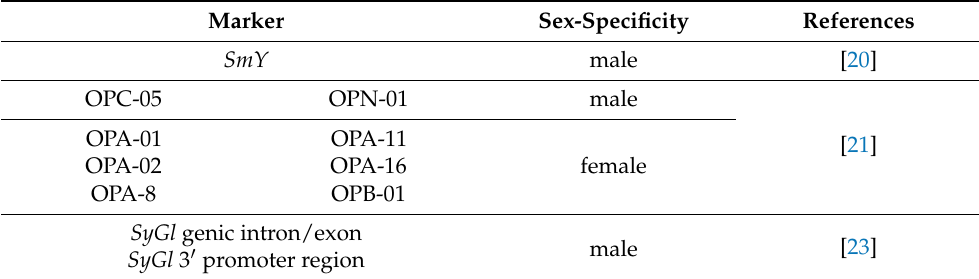
Table 3. Sex-linked molecular markers. Marker